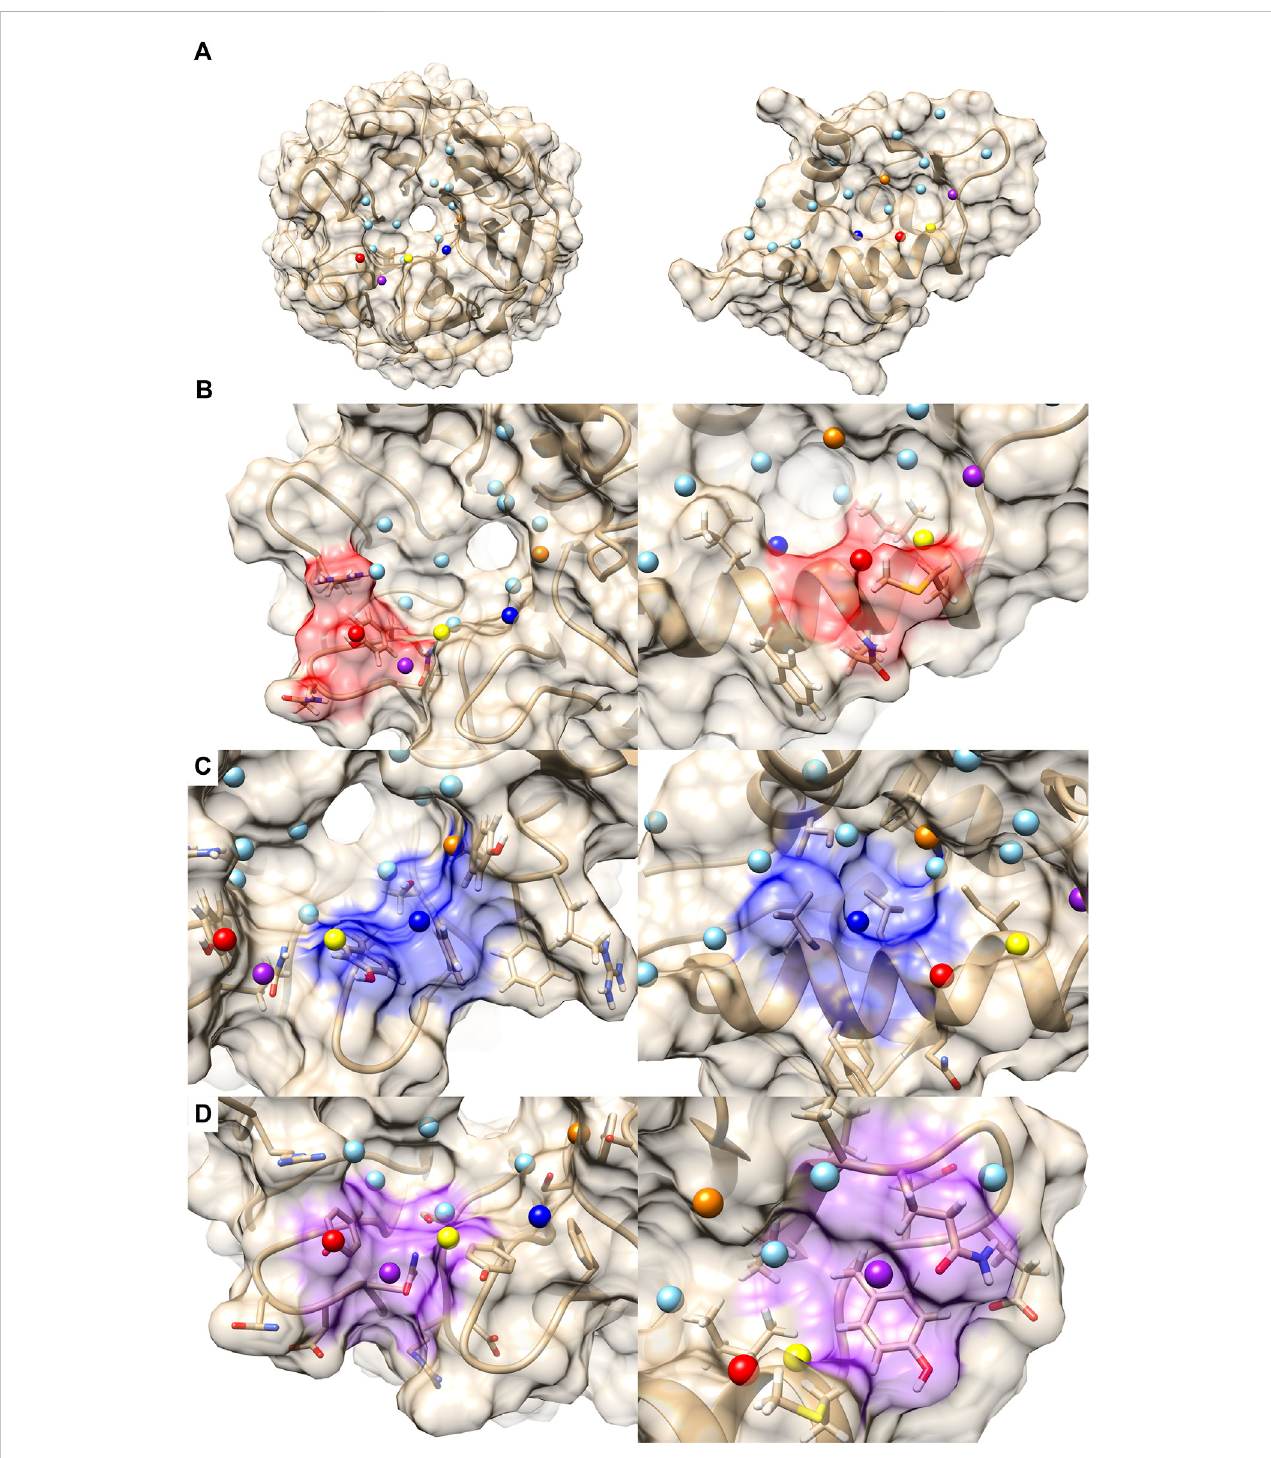
FIGURE 5 Comparison with2FLUXPand1YCRAB,whichareclustered inthePPIScore-basedclustering. (A) MolecularsurfacesofKEAP1(2P2IID:2FLUXP,left)and MDM2 (2P2I ID: 1YCRAB, right) and seed points (center of patches, sky blue sphere). The seed points of patch pairs identi fi ed by PPI-Surfer are colored in red, blue,purple, orange,andyellow.Thepairshavethesamecolorcodes. (B – D) Seedpointsofthepatchpairsandmolecular surfaceregionsthatarecloserthan 6 Å from the seed points. Patch #11 of KEAP and #6 of MDM2 red, panel (B) , patch #3 of KEAP and #5 of MDM2 blue, panel (C) , and patch #13 of KEAP and #11 of MDM2 purple, panel (D) . The KEAP patches are shown on the left and MDM2 patches are shown on the